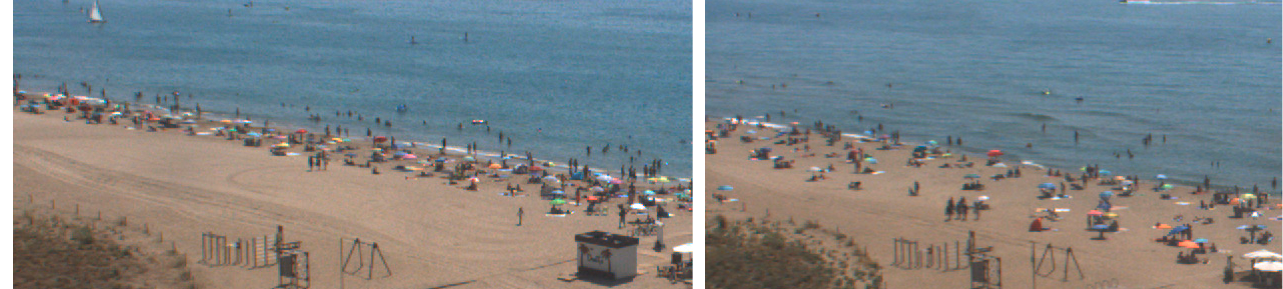
Figure 8. Different spatial distribution patterns with maximum beach occupancy levels in 2018 ( left ) and 2020 ( right ).